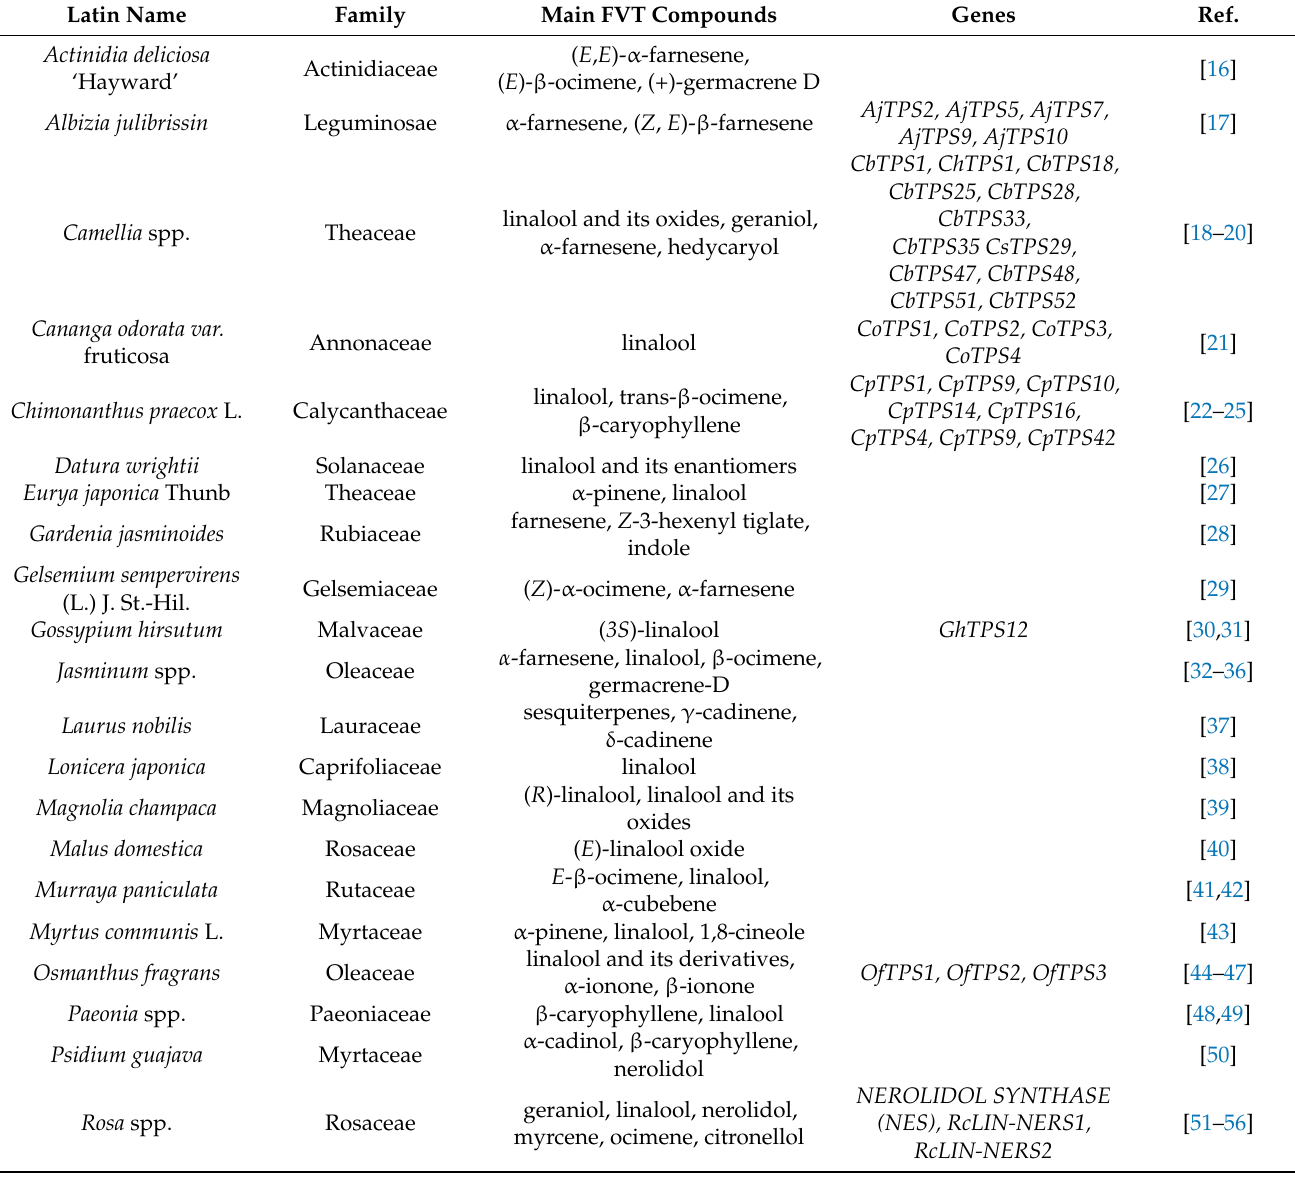
Table 1. Major FVTs and genes associated with their biosynthesis in flowering